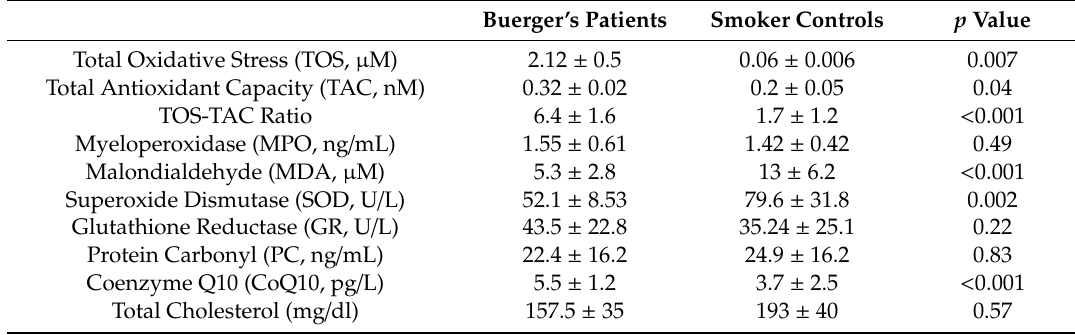
Table 1. Serum levels of soluble biomarkers in patients with Winiwarter-Buerger disease vs. smokers as control